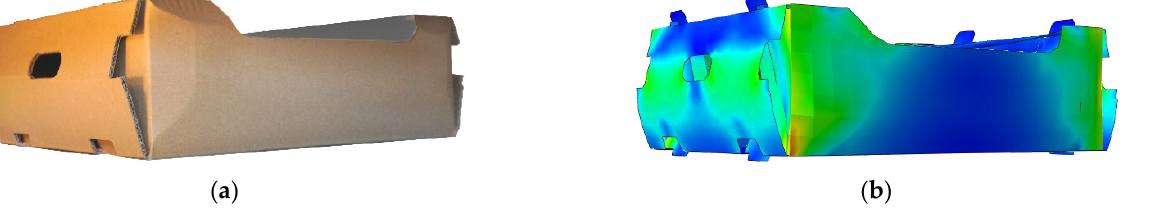
Figure 5. Model validation: ( a ) the box sample during the test and ( b ) its numerical counterpart at maximal strength (maximum reaction force value).